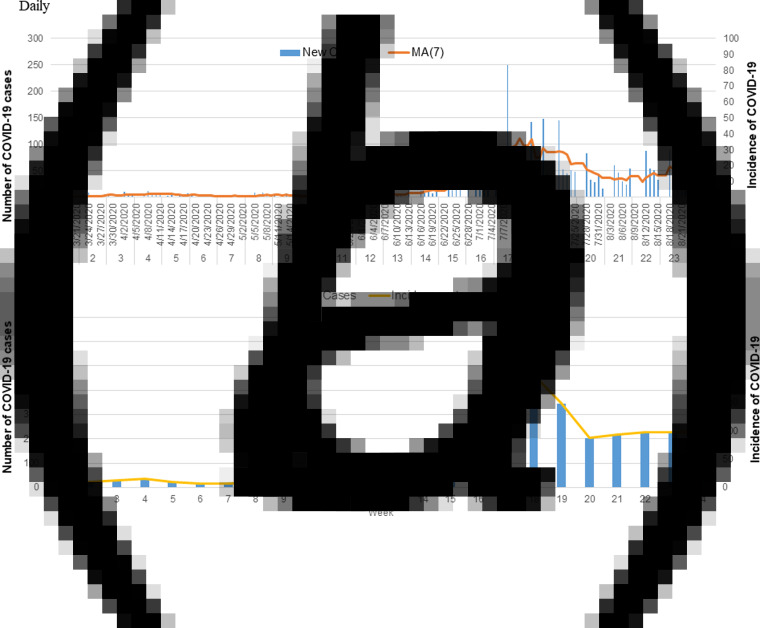
New COVID-19 cases and incidence rate per 100 000 population of the Smith County daily (panel A) and weekly (panel B). Left vertical axis represents number of COVID-19 cases. Right vertical axis represents incidence rate of COVID-19.